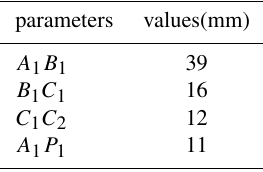
Table 2. Length parameters of